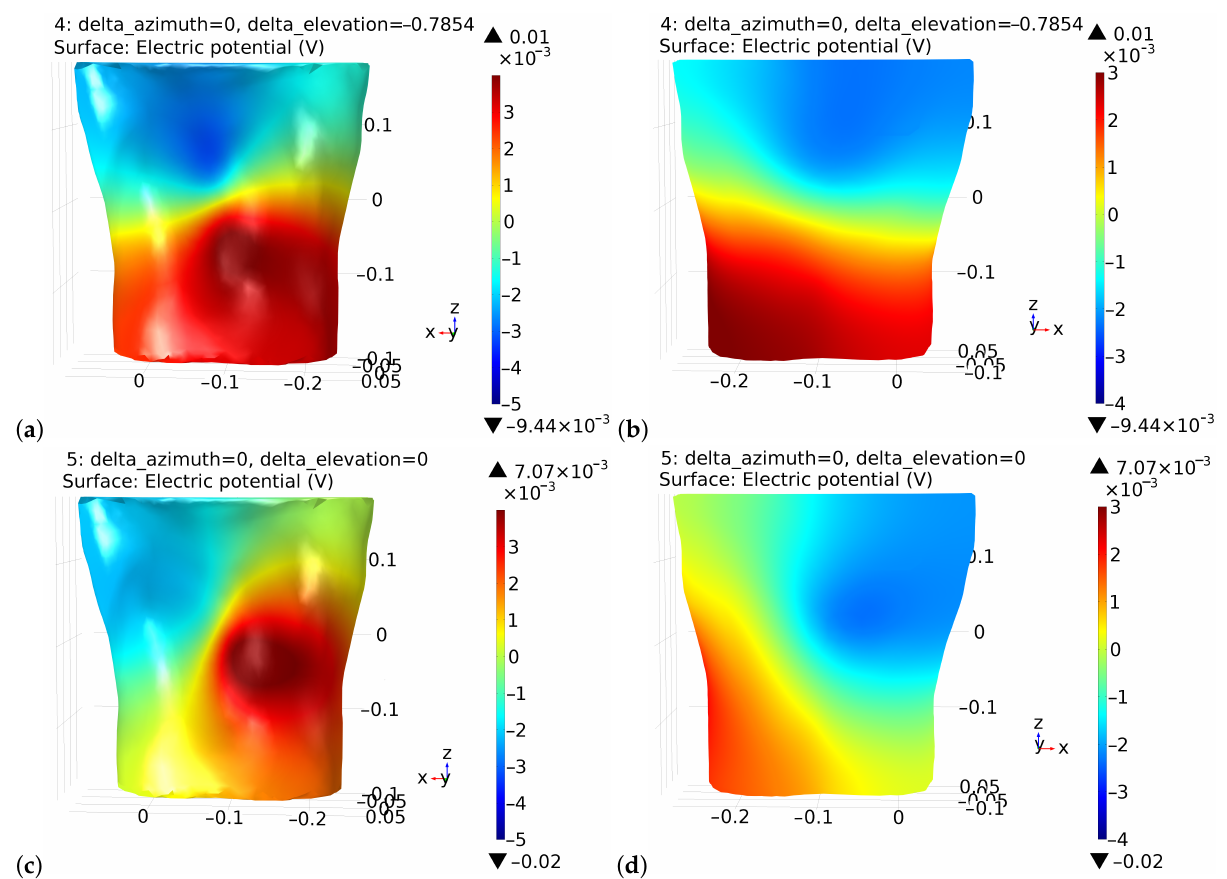
Figure 3. Exemplary results of the potential distribution, on the chest and back, respectively, at the moment of the R wave of the ECG for two selected heart axis directions which differ in the azimuthal angle value, ( a , b ) present the potential distribution, respectively, on the chest and the back for azimuthal angle π /2, while ( c , d ) present the potential distribution, respectively, on the chest and the back for azimuthal angle 3 π /4. Note that the azimuthal angle is determined in reference to the x-axis and that different scales are accepted for the